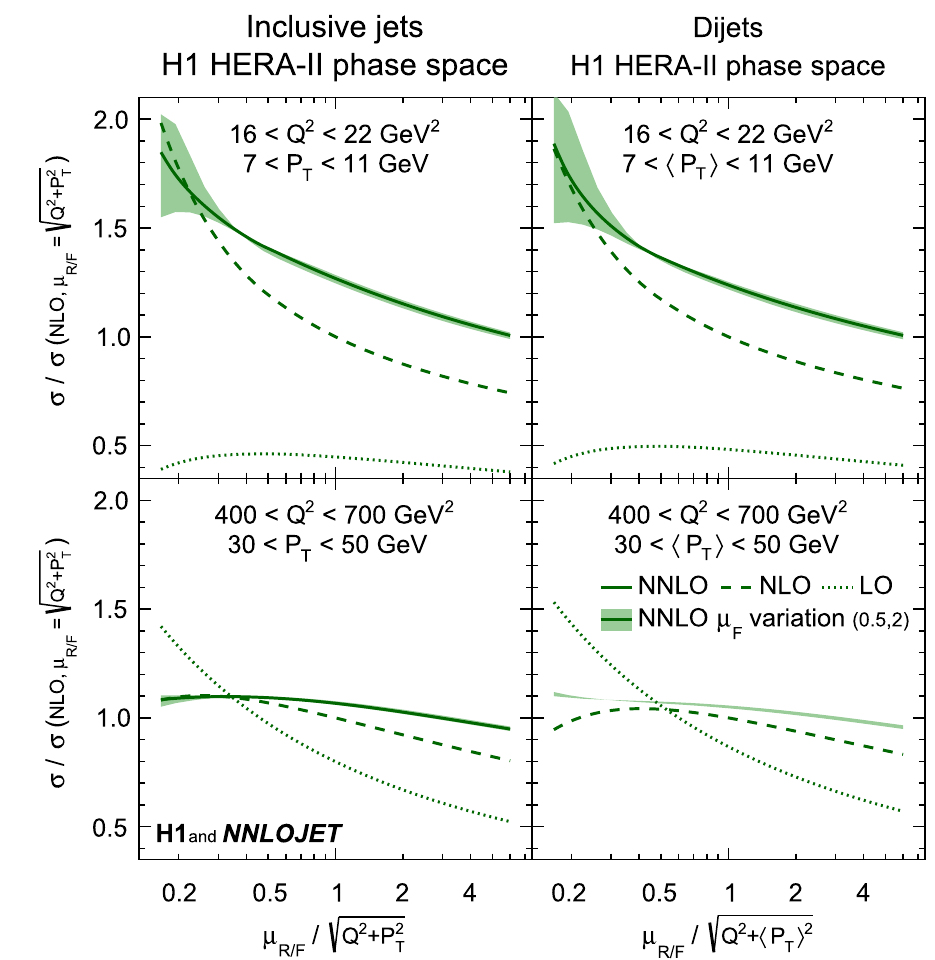
Fig. 1 Relative change of jet cross section as a function of a multiplicative factor applied to the renormalisation and factorisation scale for four exemplary data points of the HERA-II phase space. The bin definitions are displayed in the respective panels. The left panels show inclusive jet cross sections, and the right panels dijet cross sections. The full line shows the cross section dependence for the NNLO, the dashed line for NLO and the dotted line for LO calculations. For better comparison, all calculations are performed with the same PDF set (NNPDF3.1 NNLO). For all panels, the cross sections are normalised to the respective NLO cross section with unity scale factor. The filled area around the NNLO calculation indicates variations of the factorisation scale by factors of 0.5 and 2 around the chosen value for μ